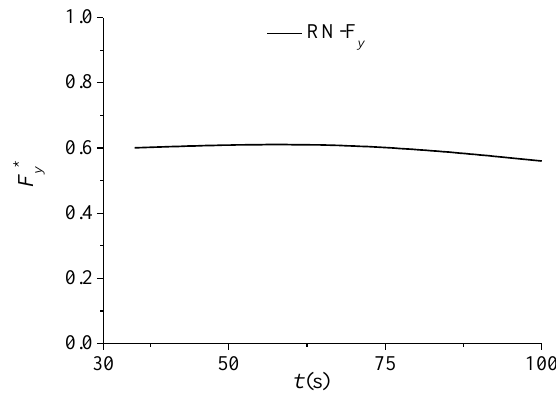
Figure 9. The axial water thrust change of the runner during no-load process. During the no-load process, the values of the flow rate, the rotation speed, and the guide vane opening of the unit are in small ranges. Therefore, under the different working conditions, A, B and C, the main frequency of pressure pulsation at each monitoring point in the runner was basically the same. The amplitude of the pressure pulsation had some differences, but the pulsation magnitude was the same. Moreover, the axial water thrust of the runner did not change much during the no-load process. Therefore, the unsteady calculation of a certain operating point can be selected to reflect the instantaneous flow characteristics of the unit in the no-load process. The following is the unsteady flow field analysis of the pump turbine under A working condition.